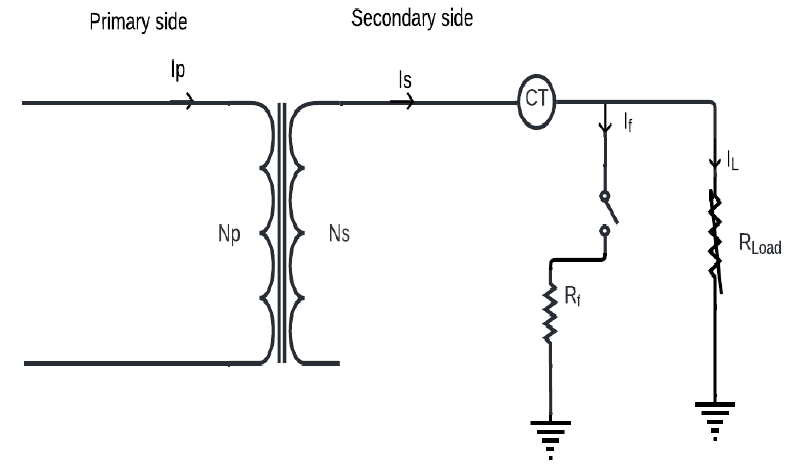
Figure 6. External fault representation.